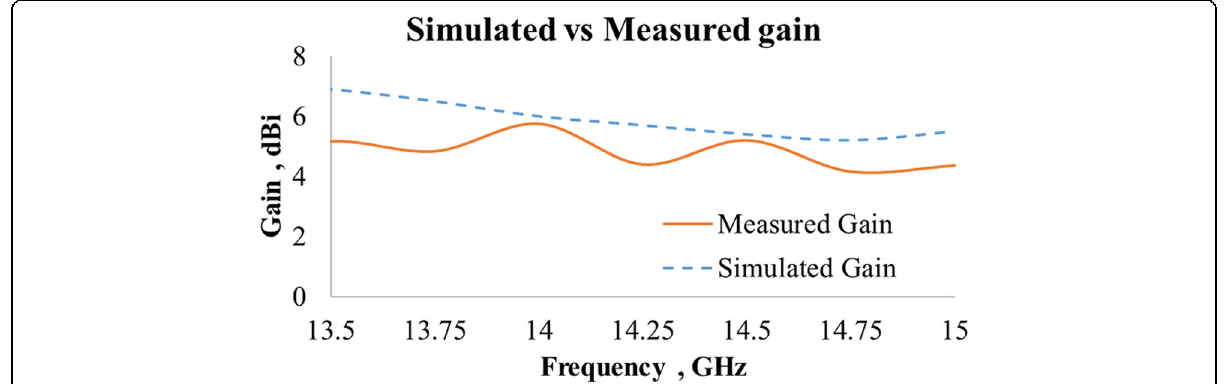
Fig. 26 Simulated and measured gain plot vs